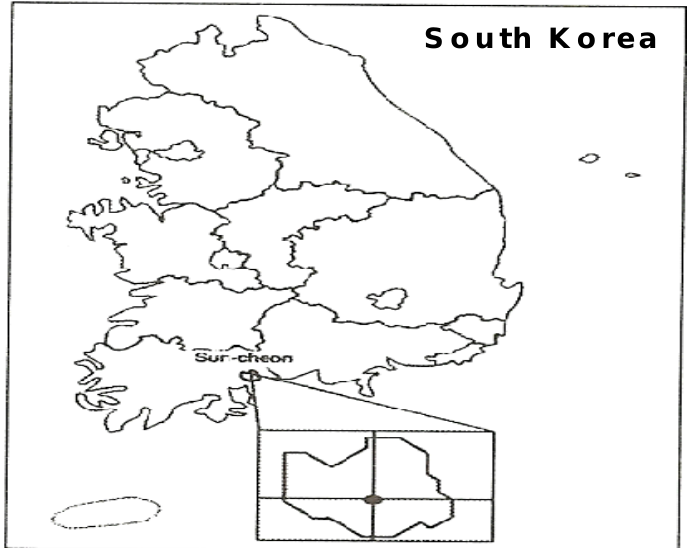
Figure 1. Location of Sun-Cheon Wastewater Treatment